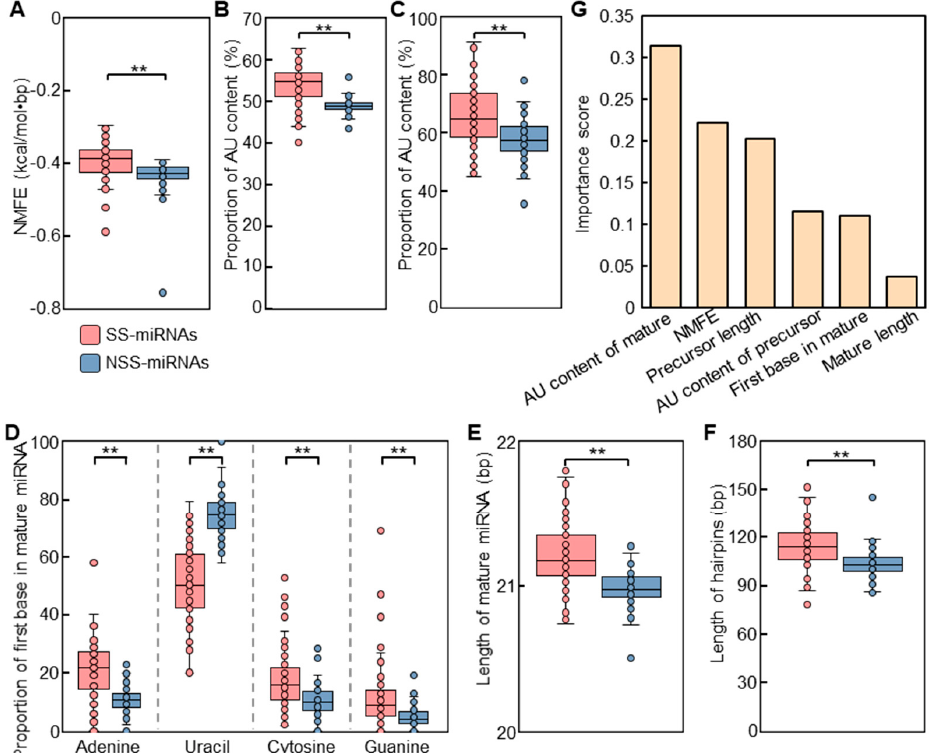
Figure 3. Comparison of features between SS-miRNAs and NSS-miRNAs. ( A ) NMFE of precursor miRNAs between SS-miRNAs and NSS-miRNAs. ( B , C ) AU contents of mature miRNAs ( B ) and precursor miRNAs ( C ) between SS-miRNAs and NSS-miRNAs. ( D ) Base composition of the first nucleotides of the 5 (cid:48) ends of mature miRNAs between SS-miRNAs and NSS-miRNAs. ( E , F ) Lengths of mature miRNAs ( E ) and hairpins ( F ) between SS-miRNAs and NSS-miRNAs. ** p < 0.01 by independent-samples t -test. The SS-miRNAs and NSS-miRNAs are colored in red and blue, respec- tively. ( G ) Assessment for the relative importance of the 12 examined features by a machine learning approach based on a gradient-boosting decision tree